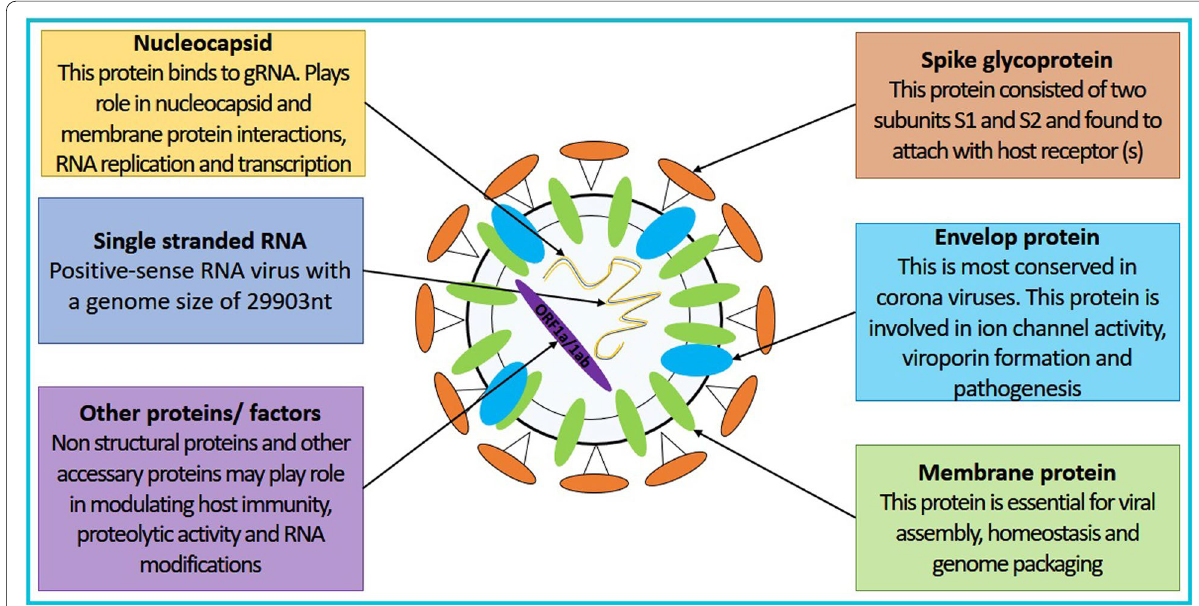
Fig. 2 SARS-CoV-2 structure. SARS-CoV-2 is a positive-sense RNA virus consisting of four structural proteins namely envelop, membrane, nucleocapsid, and spike. It also has 16 non-structural proteins and 9 accessory